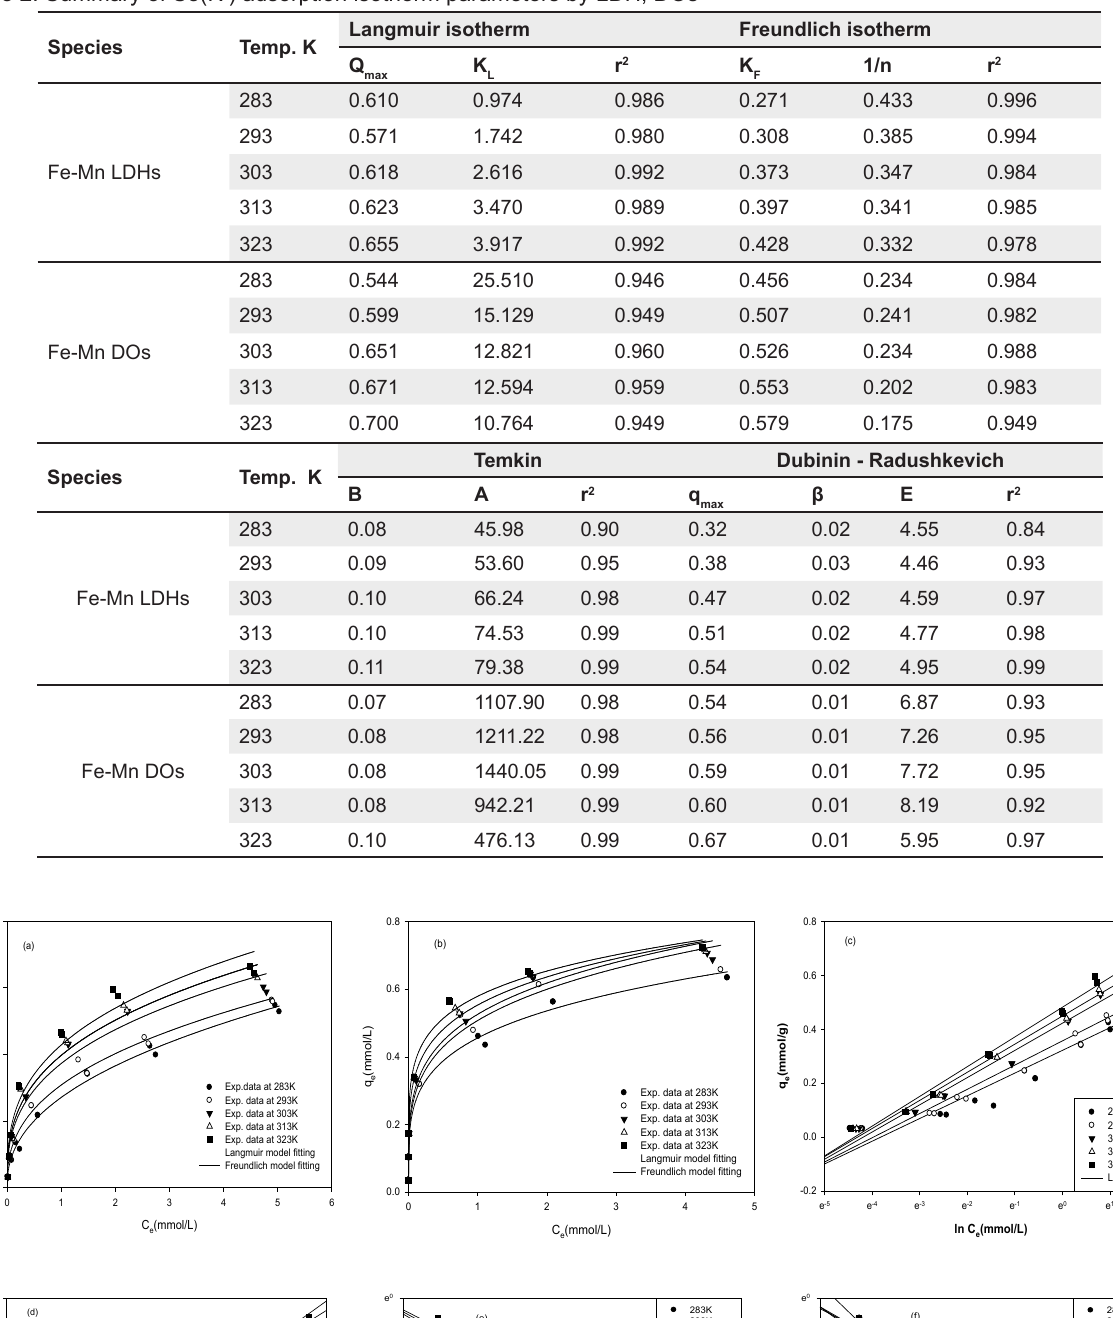
Table 2. Summary of Se(IV) adsorption isotherm parameters by LDH, DOs